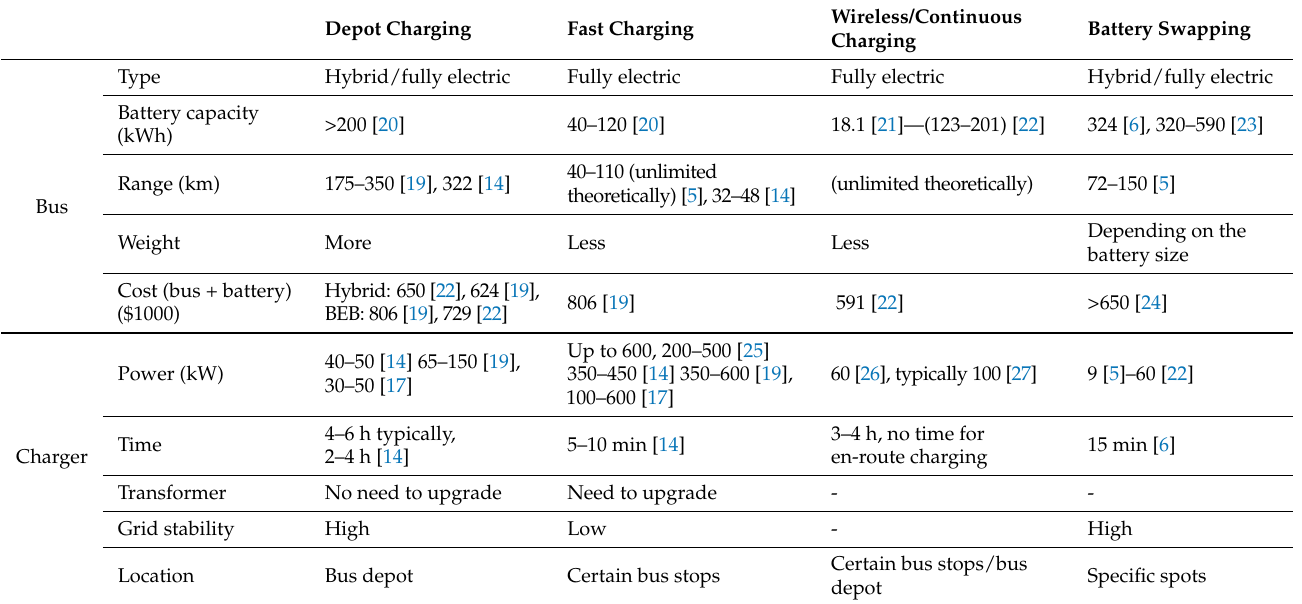
Table 2. Recommended features of buses and charging stations as a function of charging